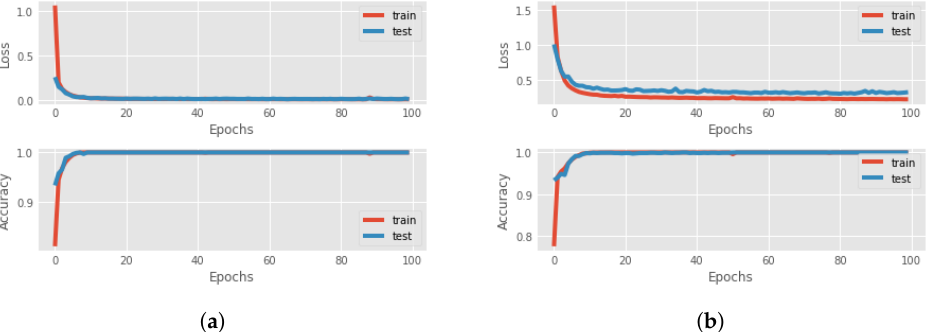
Figure 8. Results of the training and test of the RNNs for the distal prediction in the Taxi environment. ( a ) Loss and accuracy of the RNN for the distal actual prediction. ( b ) Loss and accuracy of the RNN for the distal counterfactual